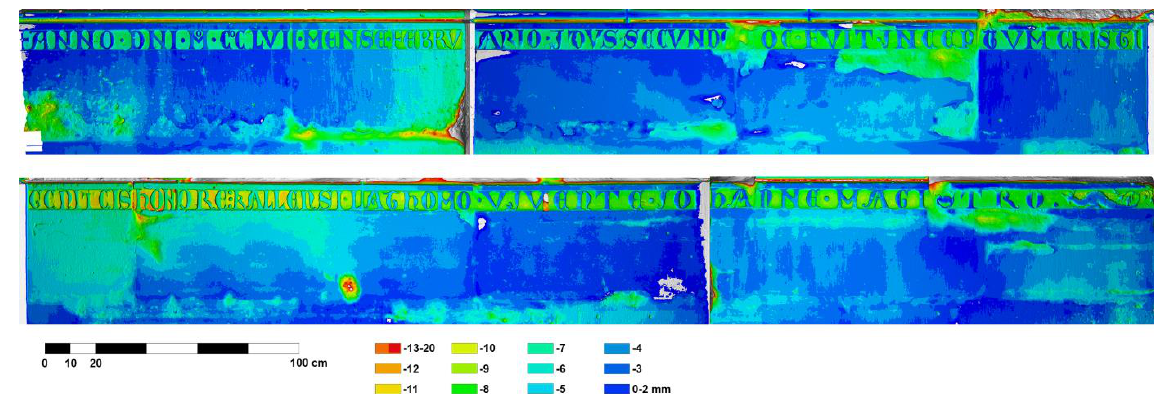
Figure 5. Depth map: western area (above), and eastern area (below). The colours show the deviation from the pedestal surface’s base level (dark blue) in 1mm steps to a depth of 2cm